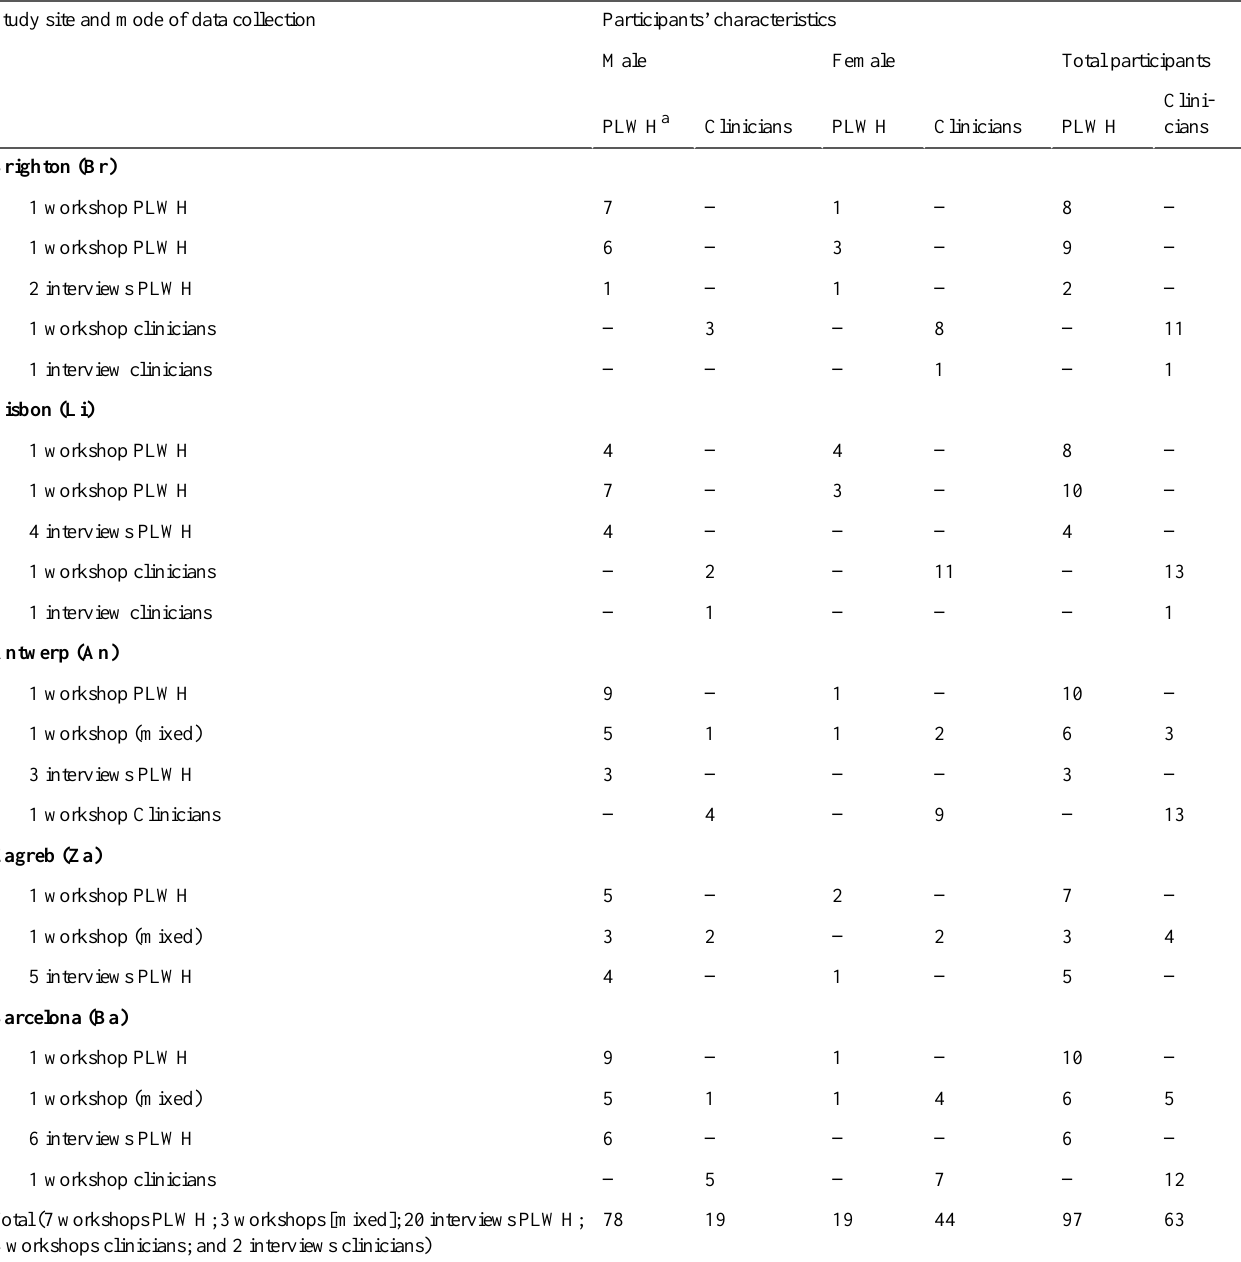
Table 1. Data collection across study sites. Participants’characteristicsStudy site and mode of data collection